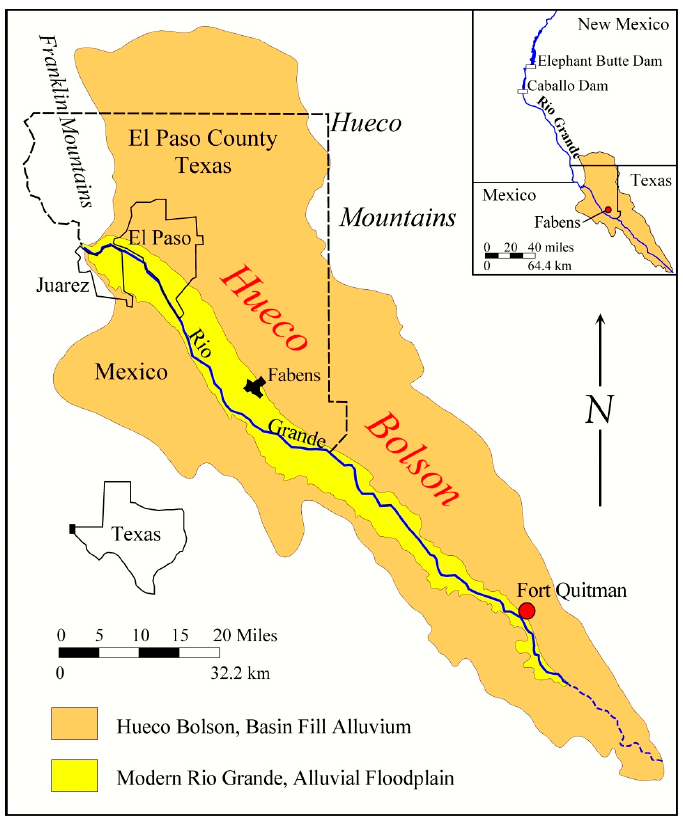
Figure 1. Regional study area map showing the extent of the Hueco Bolson and modern Rio Grande floodplain. The study area is centered near Fabens, Texas.